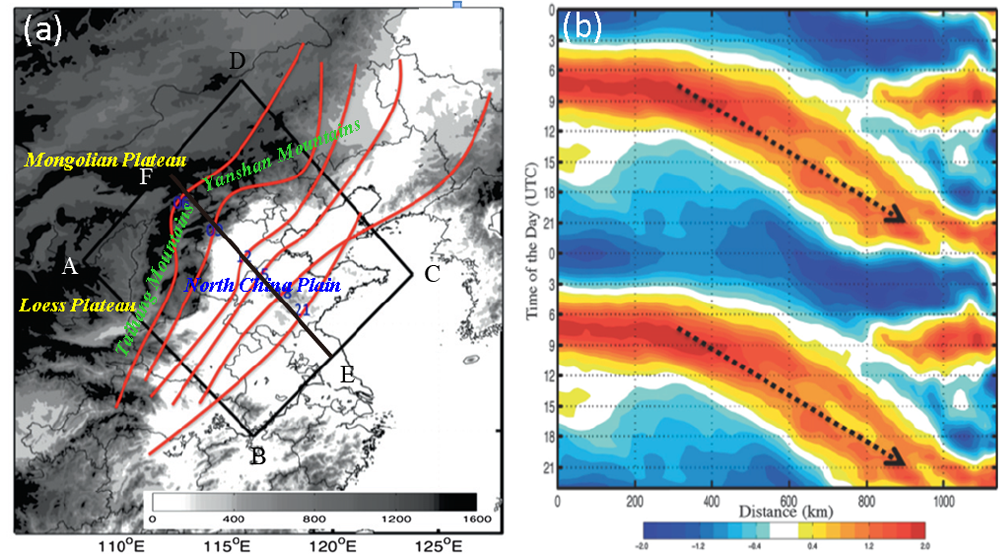
Fig. 1. (a) Isochrones (phase fronts) of the local diurnal precipitation peaks at different times with terrain elevation shaded every 200m. The labels of the isochrones are in UT (8h behind the local standard time, Beijing time). From Fig. 2b of HZ10. (b) Distance–time Hovm¨oller diagram of the normalized hourly precipitation deviation without filtering averaged along the northwest–southeast cross section within the black box in (a) . The dashed arrows show the southeastward phase propagation of the diurnal precipitation peaks. From Fig. 4 of